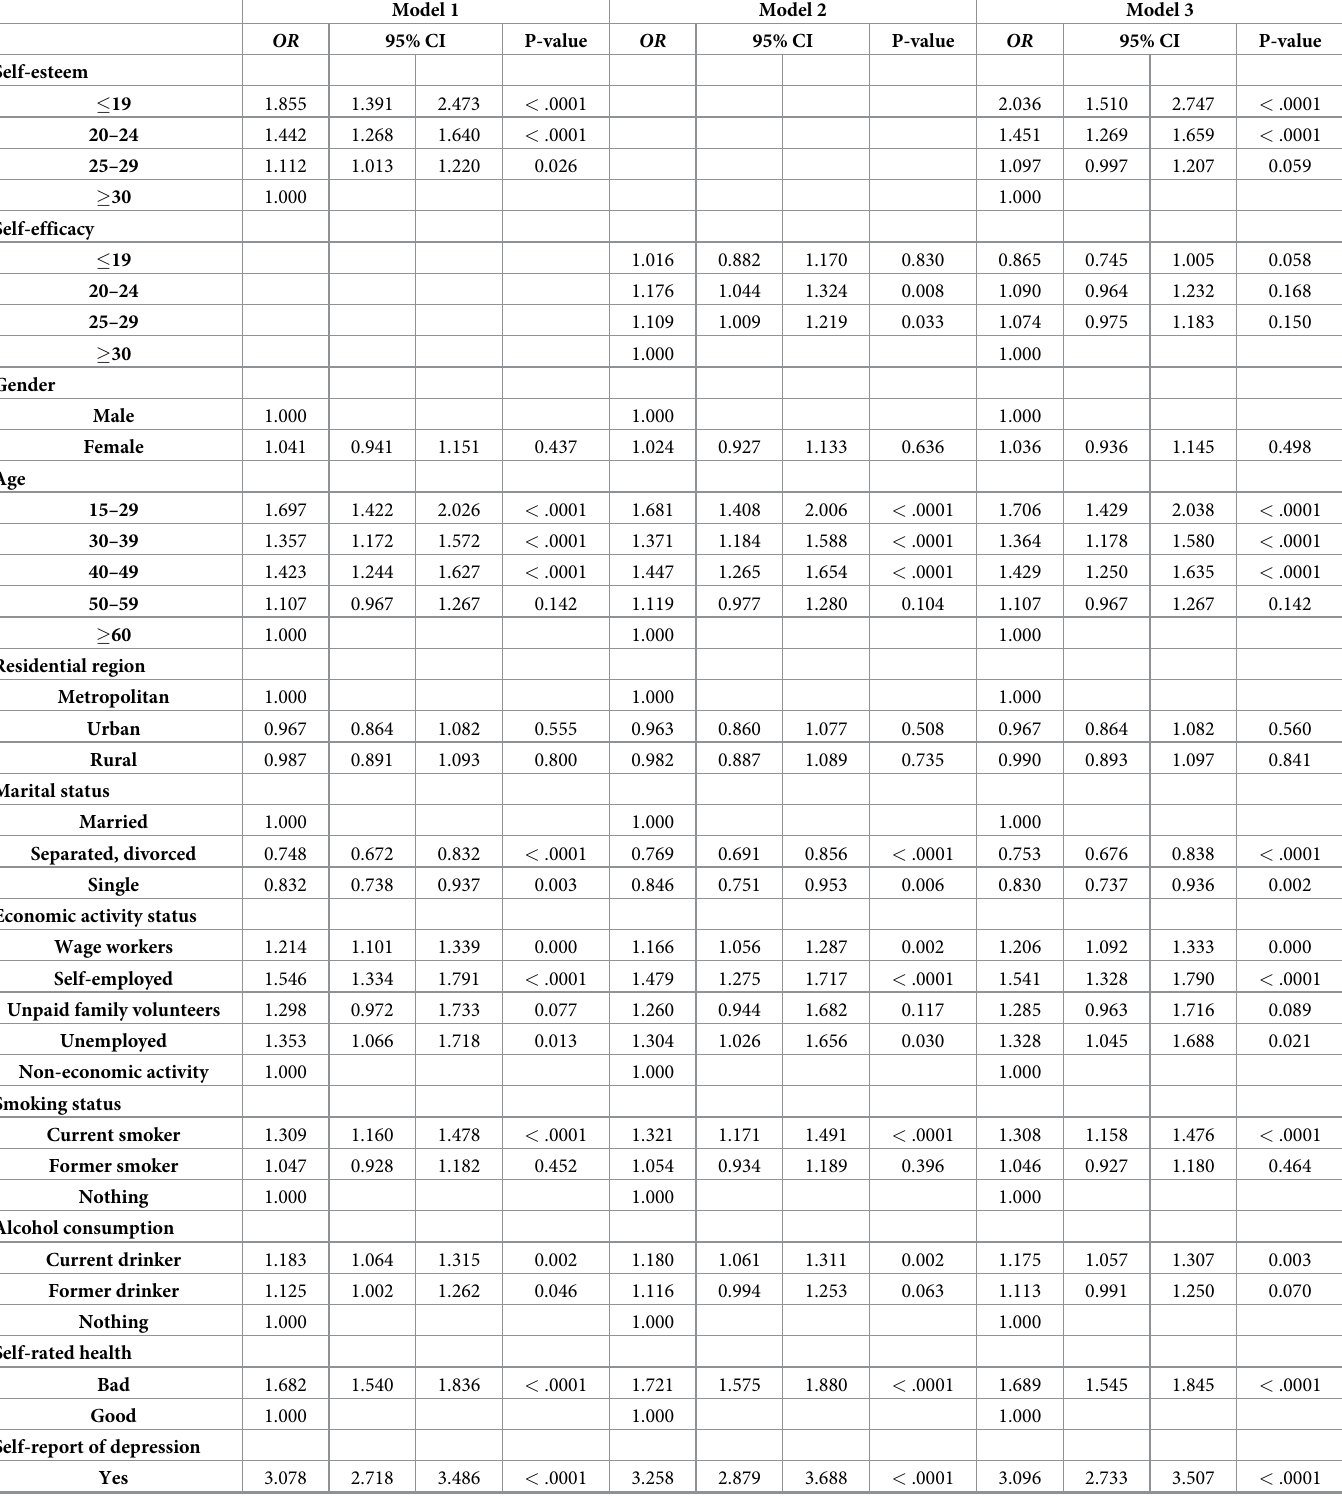
Table 3. Association between self-evaluation and perceived